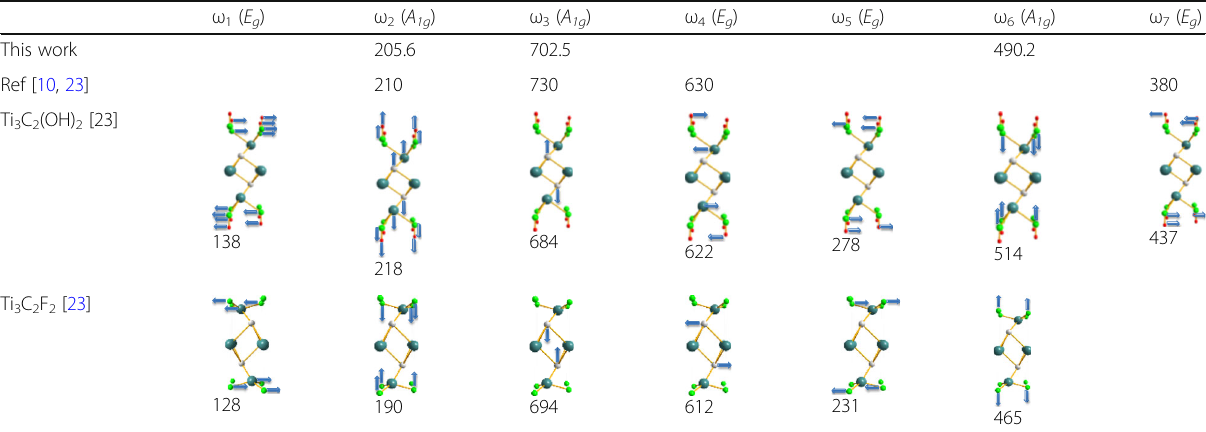
Table 2 Assignment of typical Raman peaks in this work and reference. The theoretically calculated phonon energies of Ti 3 C 2 (OH) 2 and Ti 3 C 2 F 2 are listed for comparison. The vibration directions of atoms in a unit cell are also shown schematically. The unit of Raman shift is cm − 1